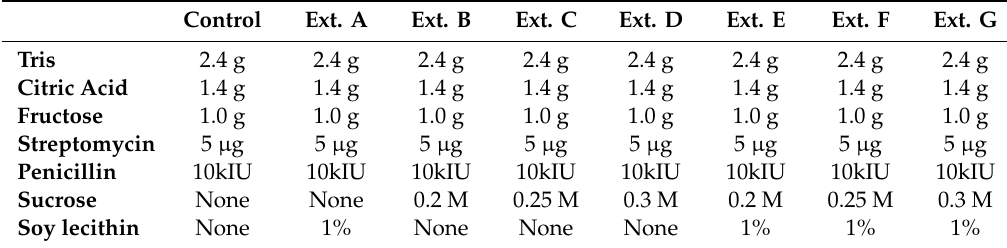
Table 1. Preparation of extenders used in the